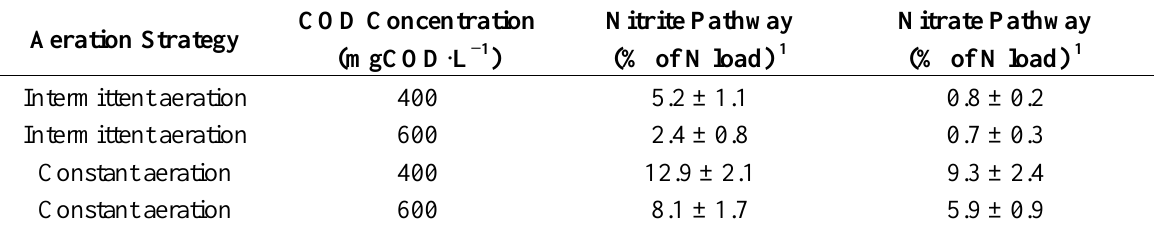
Table 2. N O emissions with N-removal over nitrite and nitrate, respectively, with 2 intermittent aeration and constant DO of